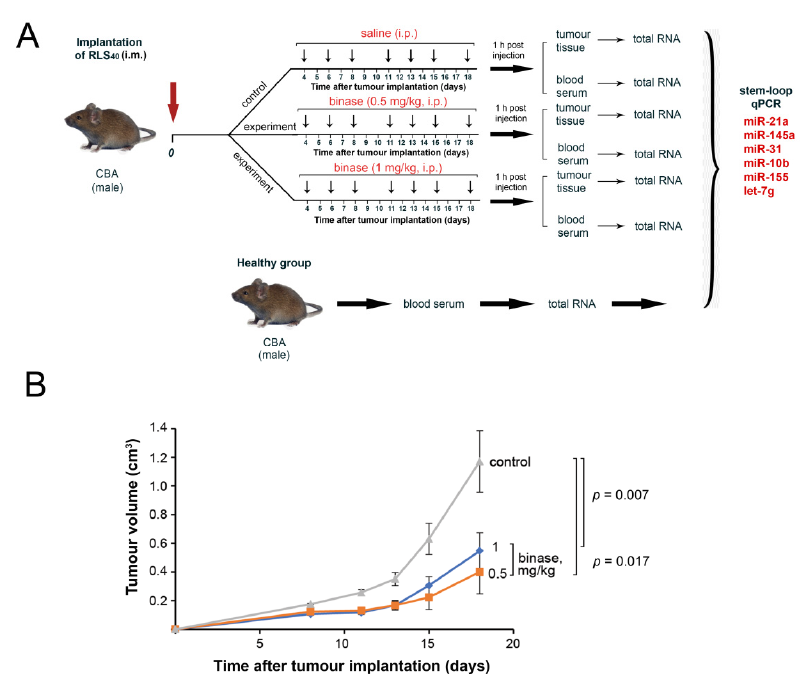
Figure 2. Effect of binase on the RLS 40 tumour progression in CBA mice. ( A ) Design of the experiment. RLS 40 cells (10 5 cells, 0.1 mL) were intramuscularly (i.m.) implanted into CBA mice. Starting on day 4